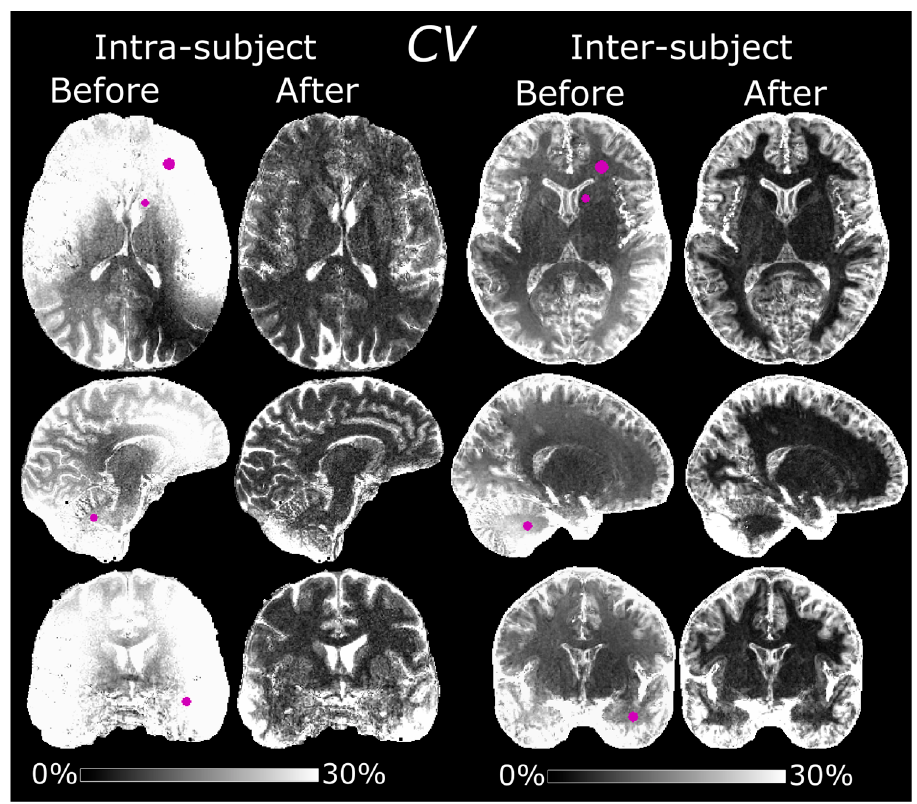
Figure 5. Maps of the CV before and after normalization, showing the intra- and inter-subject variability. The intra-subject CV maps were calculated from data acquired at five scanning sessions under an eight-month period. The inter-subject CV maps, in MNI space, were calculated from data acquired from 10 separate subjects. Reproducibility was improved after normalization in both cases. The ROIs corresponding to the data in Table 2 are denoted in purple in the “Before” maps. Table 2. ROI analysis of the CV maps in Figure 5.